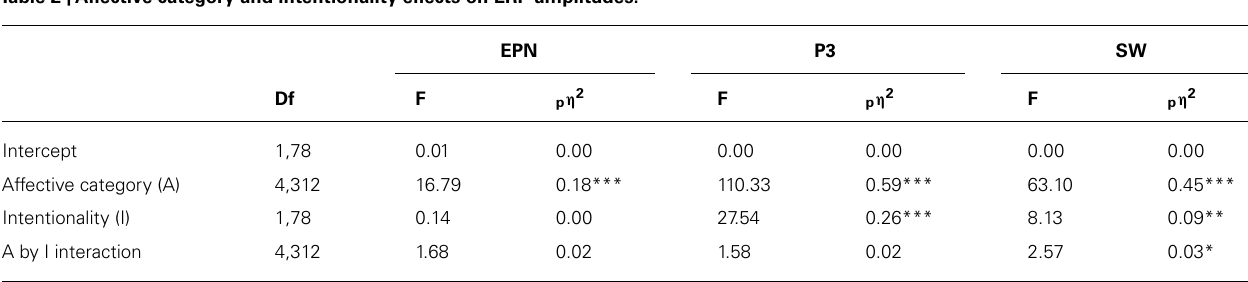
Table 2 |Affective category and intentionality effects on ERP amplitudes.